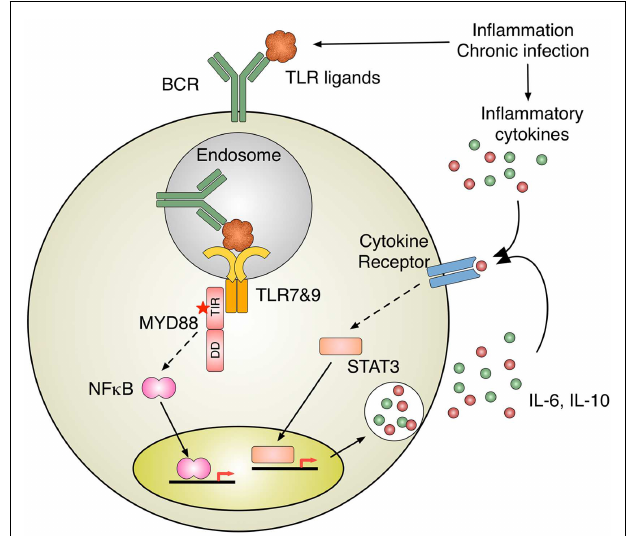
FIGURE 2 | Inflammation induces B cell activation .TLR activation by nucleic acid–protein complexes derived from inflammation and MYD88 mutation B cell antigen receptor (BCR) delivers nucleic acids–protein complexes toTLR-containing endosomes, where MYD88 initiates the activation of intracellular signaling pathways, such as NF κ B. Intriguingly, oncogenic MYD88 mutations require intactTLR apparatuses to recognize nucleic acids. One of the potential sources forTLR ligands is nucleic acid–protein complexes derived from inflammation and chronic infection. A subset of ABC-DLBCL shows constitutively activation of JAK-STAT3 pathway, presumably due to autocrine stimulation by IL-6 and IL-10.The activation of cytokine receptor signaling can also be induced by inflammatory cytokines in the milieu of inflammation and chronic